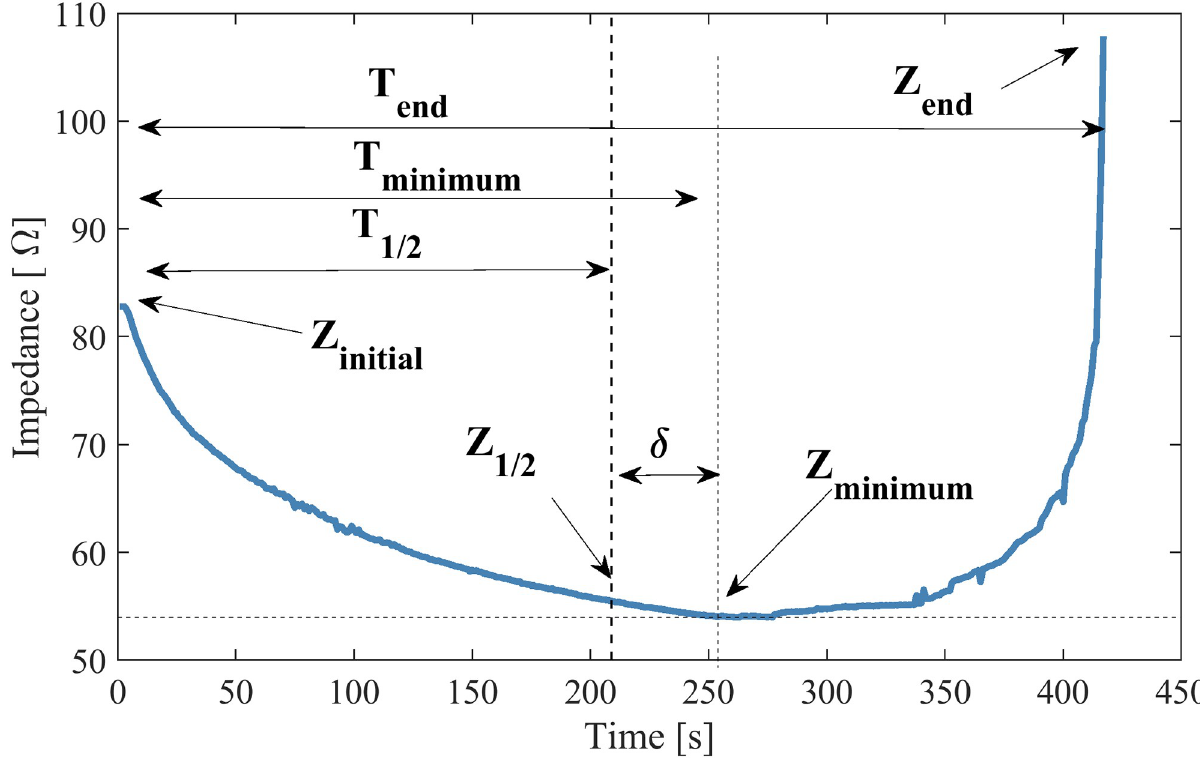
Fig 2. Impedance parameters. This figure illustrates time and impedance parameters for an ex vivo bovine tissue ablation curve.